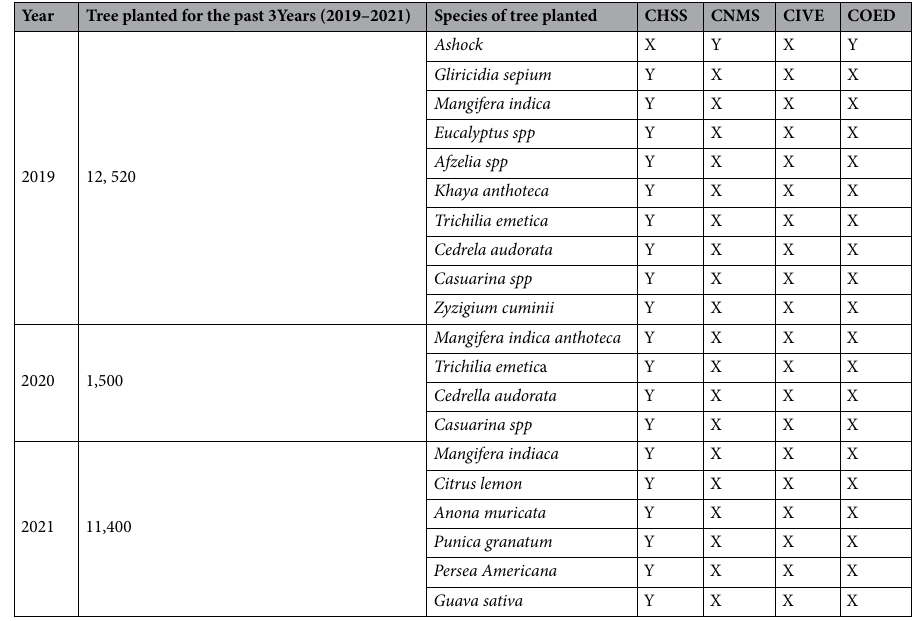
Table 1. Tree species planted in UDOM for afforestation program in three years (2019–2021). CNMS , college of natural and mathematical science; CHSS , college of humanities and social science; CIVE , college of informatic and virtual education; COED , college of education; Y , planted species; X , not